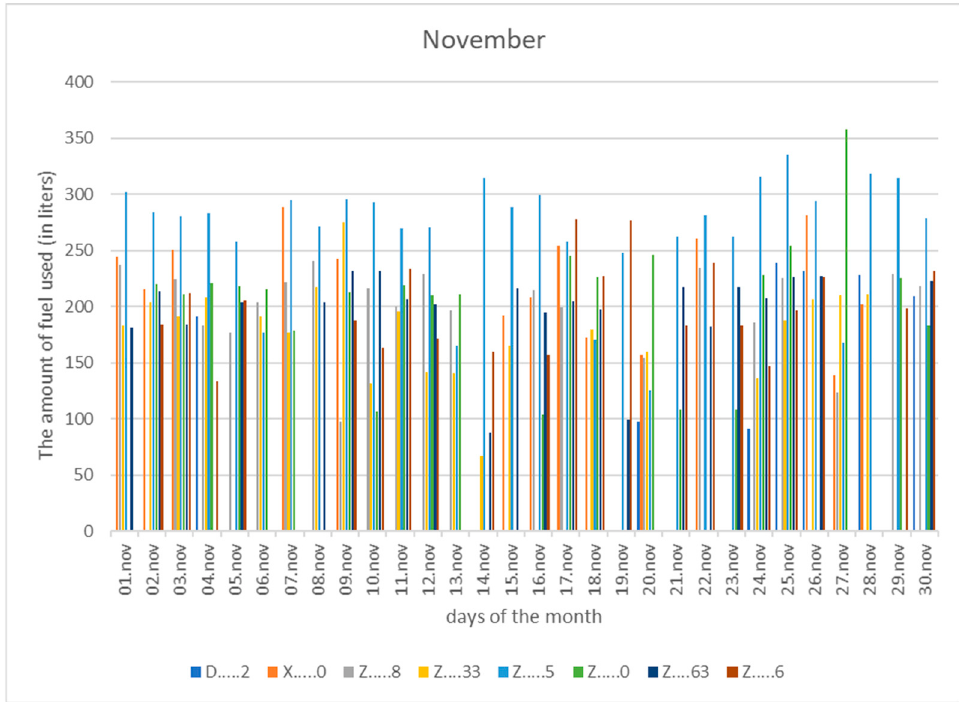
Figure 4. The amount of fuel used (in litres) for each vehicle in November.